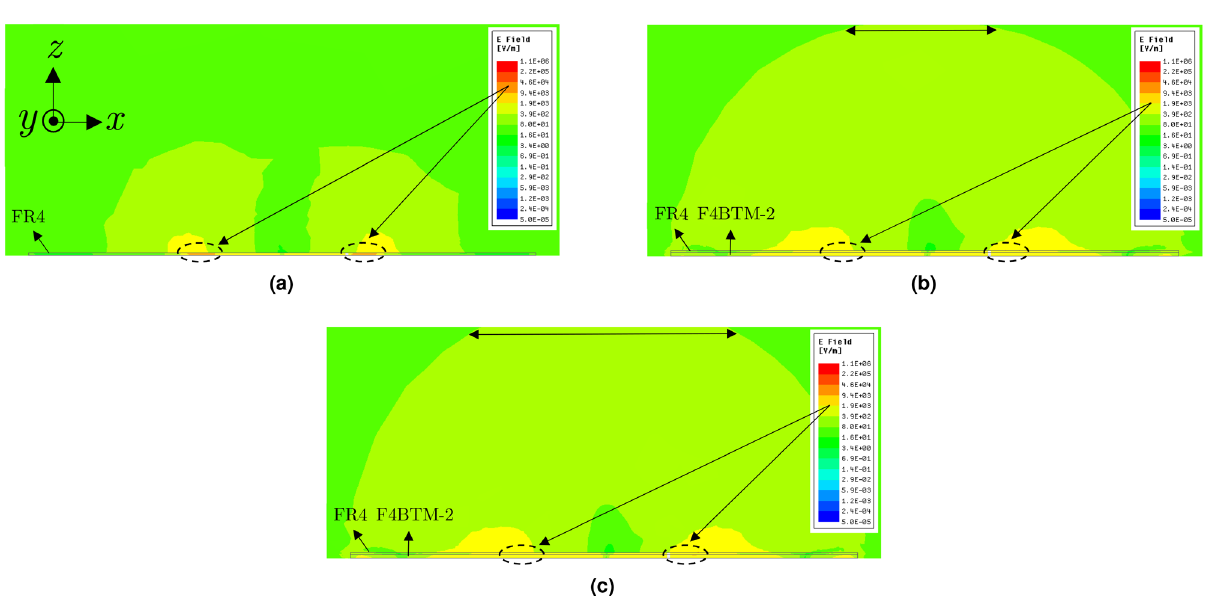
Figure 7. Surface current contributions on the unit-cell array at 868 MHz with ( a ) 6 matrix. Scale: logarithmic with 15 subdivisions ranging from 0.06 to 60 A/m.